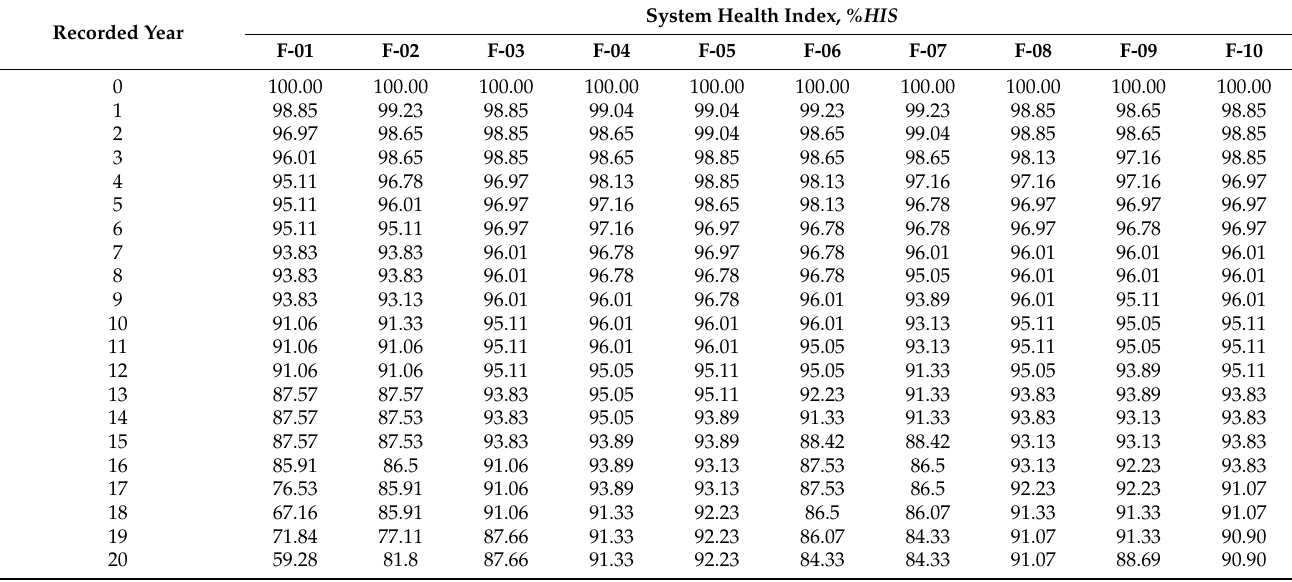
Table 8. Summary of remaining life estimation results and related parameters of ten cable